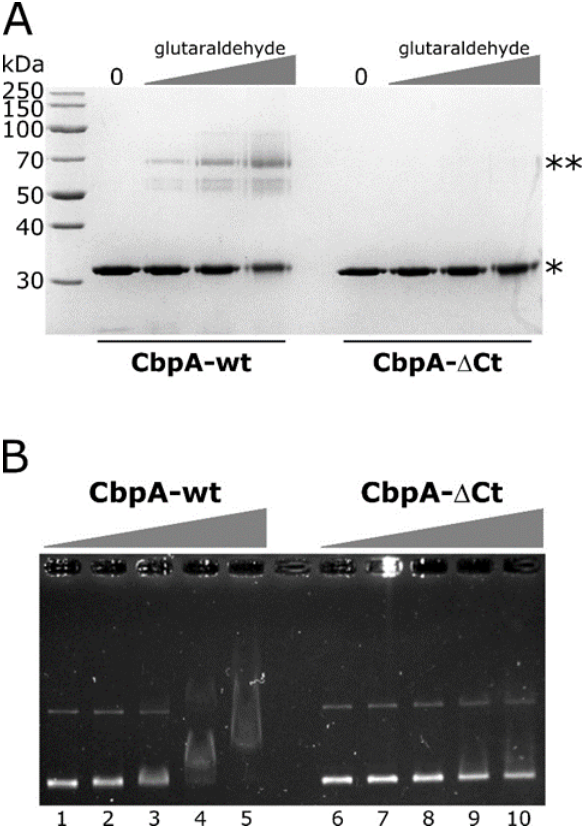
Figure 4. In vitro crosslinking and EMSA assays of CbpA-wt and CbpA- ∆ Ct proteins. Panel ( A ) SDS-PAGE of the purified CbpA-wt and CbpA- ∆ Ct proteins not treated (lane 0) or treated with increasing concentrations of glutaraldehyde. Symbols: *, band of the monomeric form of the proteins; **, band of the putative dimeric form of the CbpA-wt protein. Panel ( B ) EMSA assay with purified H. pylori CbpA-wt and CbpA- ∆ Ct proteins. The pHel2-flaAfur plasmid was incubated with 0, 75, 150, 300 and 600 nM of purified CbpA-wt (lanes 1 – 5 ) or CbpA- ∆ Ct (lanes 6 – 10 ) at 25 ◦ C for 25 minutes before electrophoretic separation through 0.9% agarose gel.